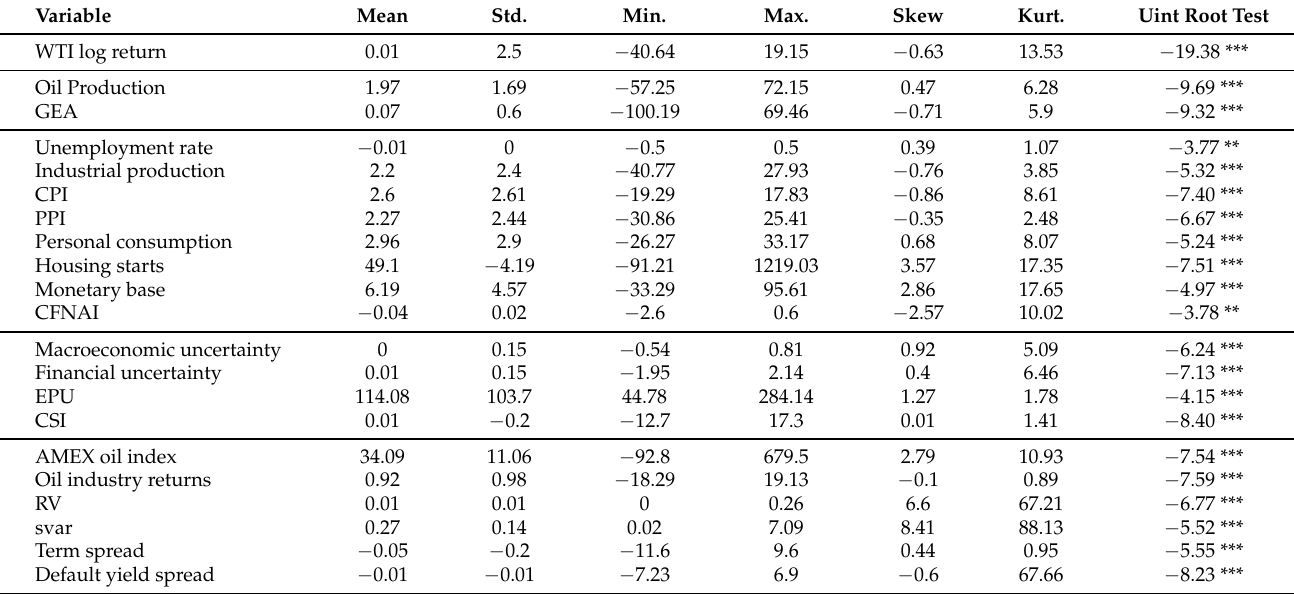
Table 1. Descriptive statistics of processed